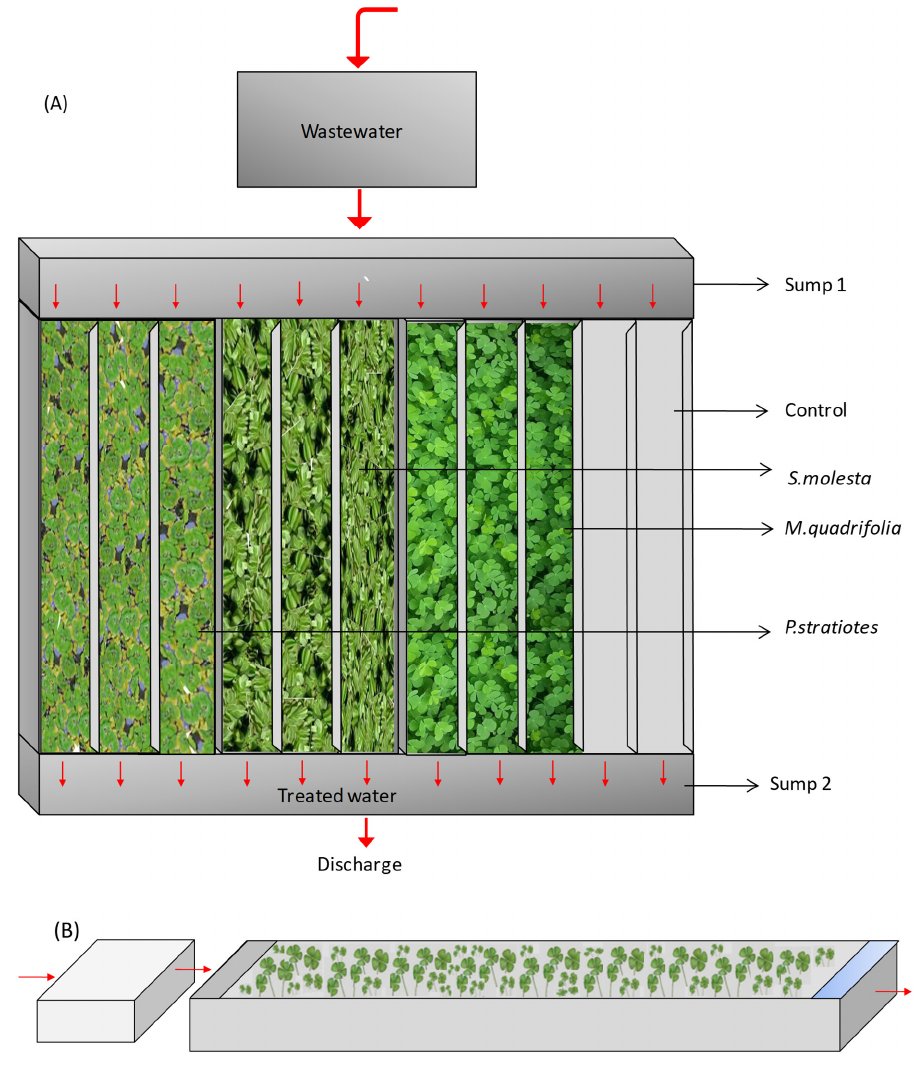
Figure 3. Schematic of SHEFROL, top view ( A ) and side view ( B ).